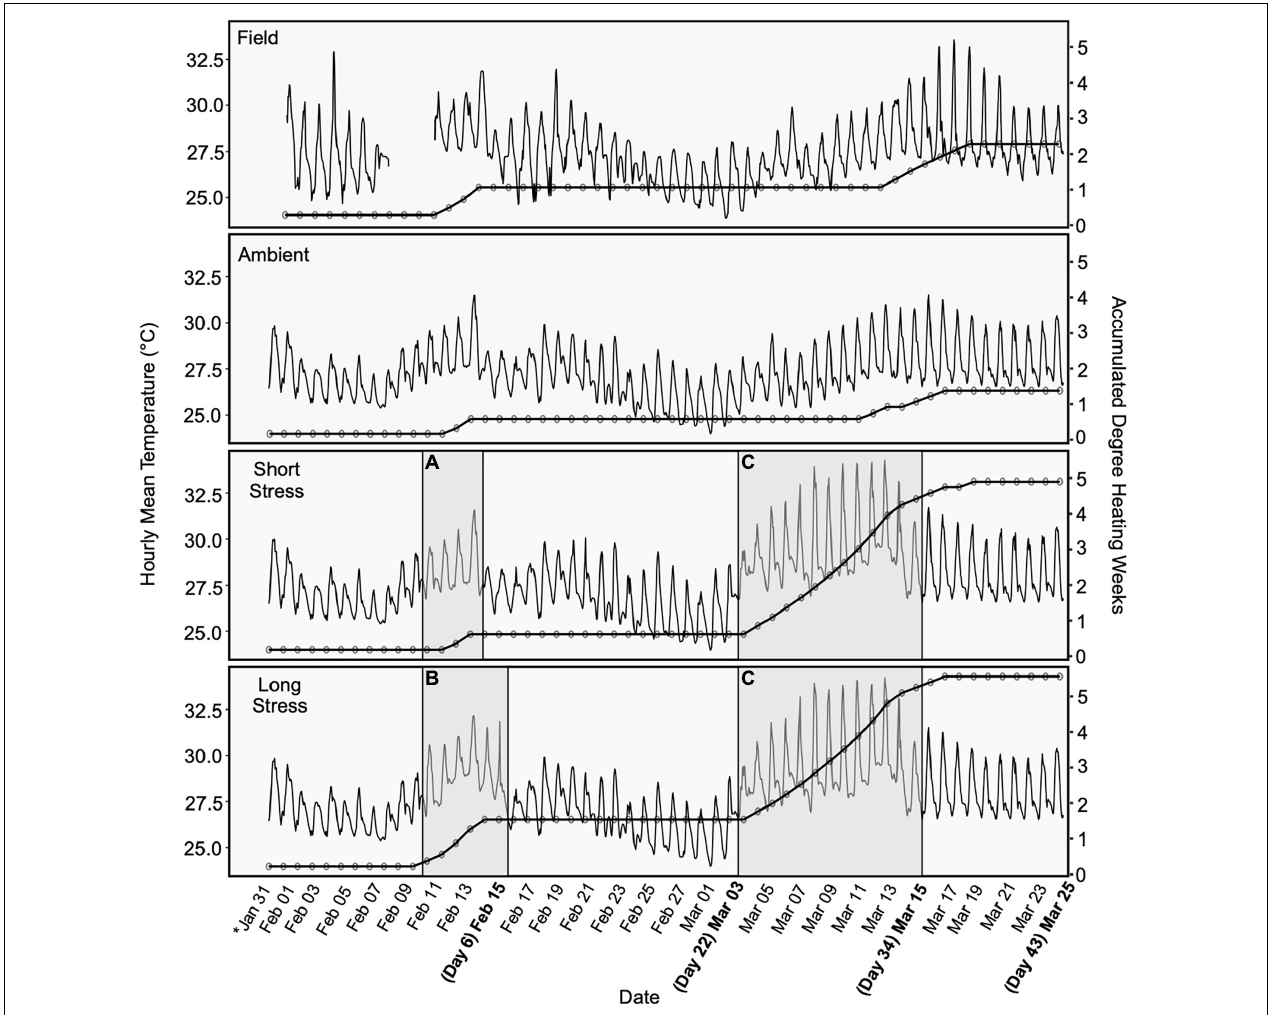
FIGURE 1 | Mean temperature (averaged by hour) for each warming trajectory, overlain with accumulated degree heating weeks (DHWs). Periods of warming are shaded showing initial sub-lethal temperature increases for (A) the short stress scenario (4 days) and (B) the long stress scenario (6 days), and an increase to bleaching temperatures for (C) both scenarios. Bold dates represent sample timepoints. DHWs continued to accumulate following the end of the warming experiment, due to above-average ambient/ in situ seawater temperatures. Field temperature data for 9–11 Feb are missing due to logger